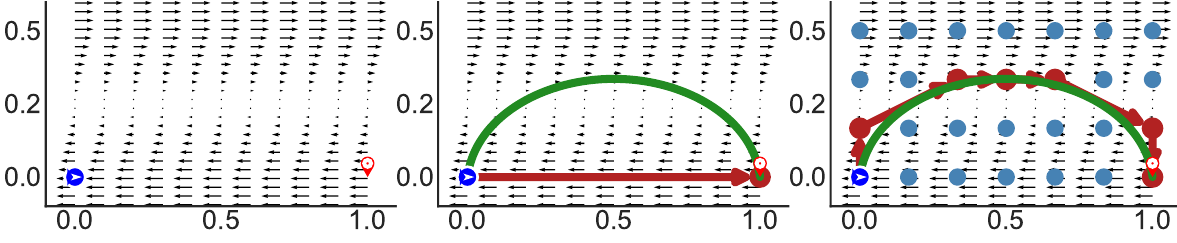
¯ v . Blue dots: network-graph with h = l 2 and 2